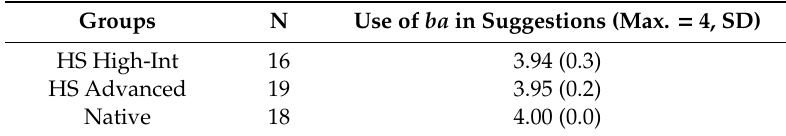
Table 4. Mean scores of all groups in the DCT concerning the [suggestion] feature of the suggestion SFP ba.